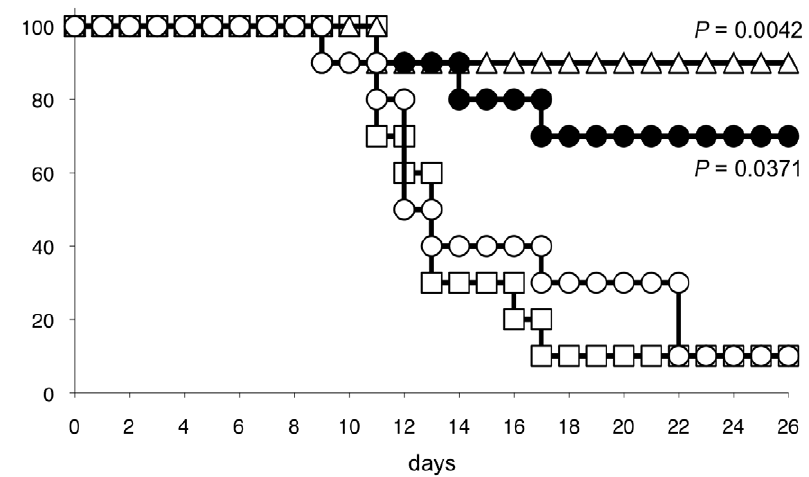
Figure 5. Efficacy of anti-LT- a mAb in Hu-SCID model of GVHD. SCID mice were sublethally irradiated, randomized, then immediately treated with anti-LT- a MLTA3698A (filled circles), anti-LT- a -FcMT (open circles), CTLA-4.Ig (open triangles) or isotype control Ab (open squares). 4 hr after initial treatment, human PBMC were transferred via i.v. injection. Treatment was continued with twice-weekly dosing throughout the study. Two independent studies were performed with similar results.